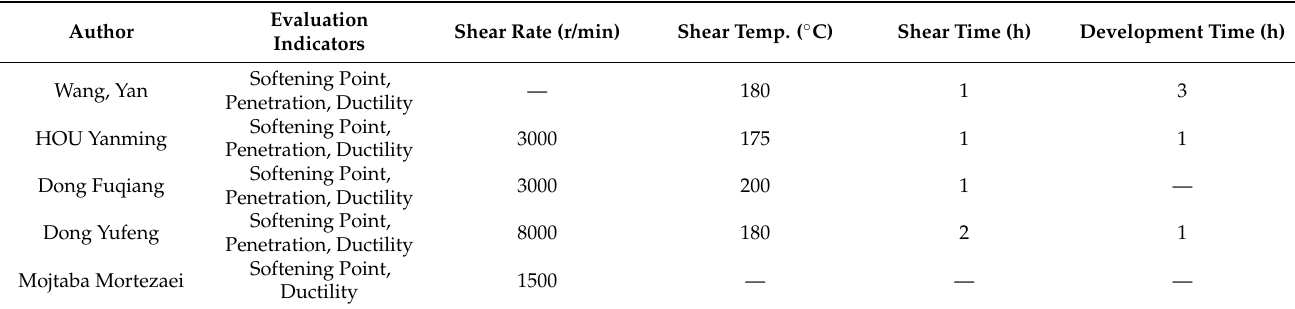
Table 1. Recommended preparation methods from the related